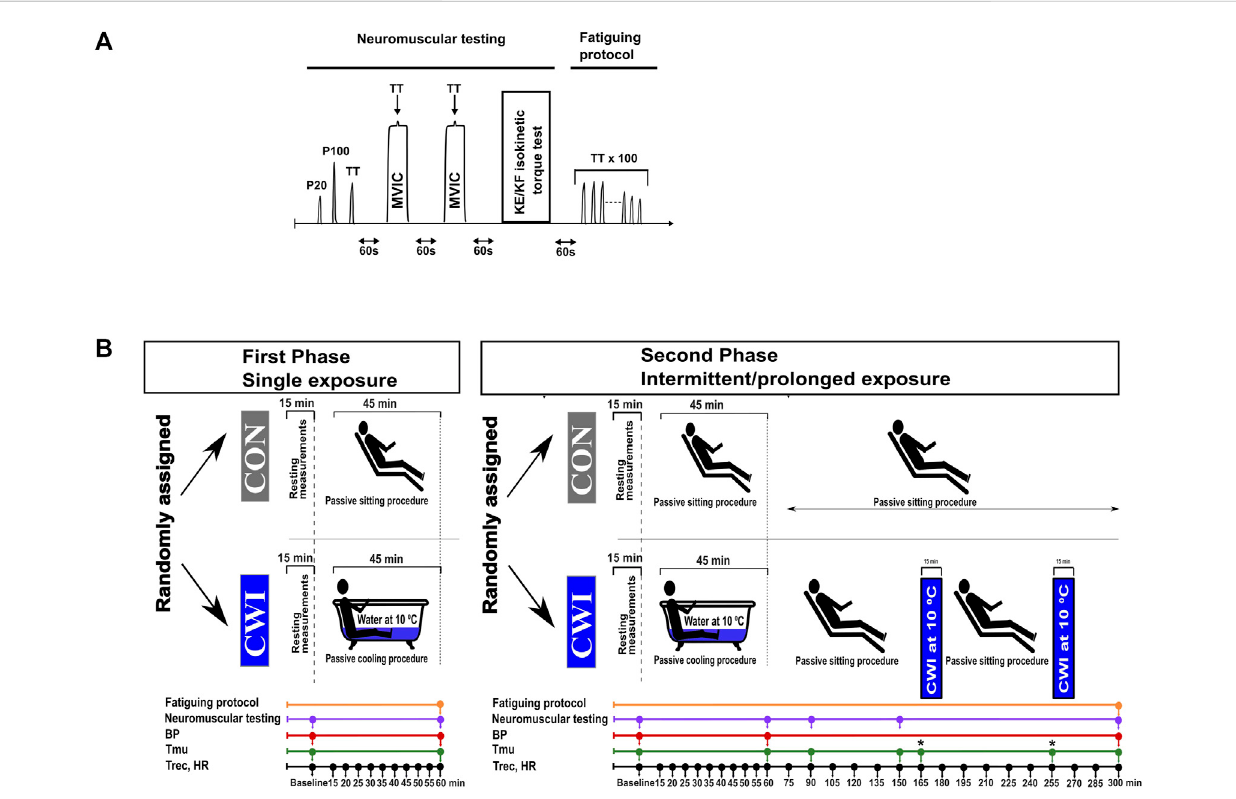
FIGURE 1 Neuromuscular testing and fatiguing protocol (A) , and experimental design (B) . P20, electrical stimulation at 20 Hz; P100, electrical stimulation at 100 Hz; TT, 250-ms test train stimulation at 100 Hz; MVIC, maximal voluntary isometric contraction; KE, knee extension; KF, knee fl exion; BP, blood pressure; Tmu, intramuscular temperature; Trec, rectal temperature; HR, heart rate; CON, control condition; CWI, cold-water immersion condition. Fatiguing protocol consisting of 100 trains of electrical stimulation of the knee extensors (100 x 250-ms TT) was only performed after the last neuromuscular testing (i.e., second neuromuscular testing during the single phase and 5th neuromuscular testing during the intermittent/prolonged phase). *: at the time points 165 and 255 min, Tmu was only measured in the CWI